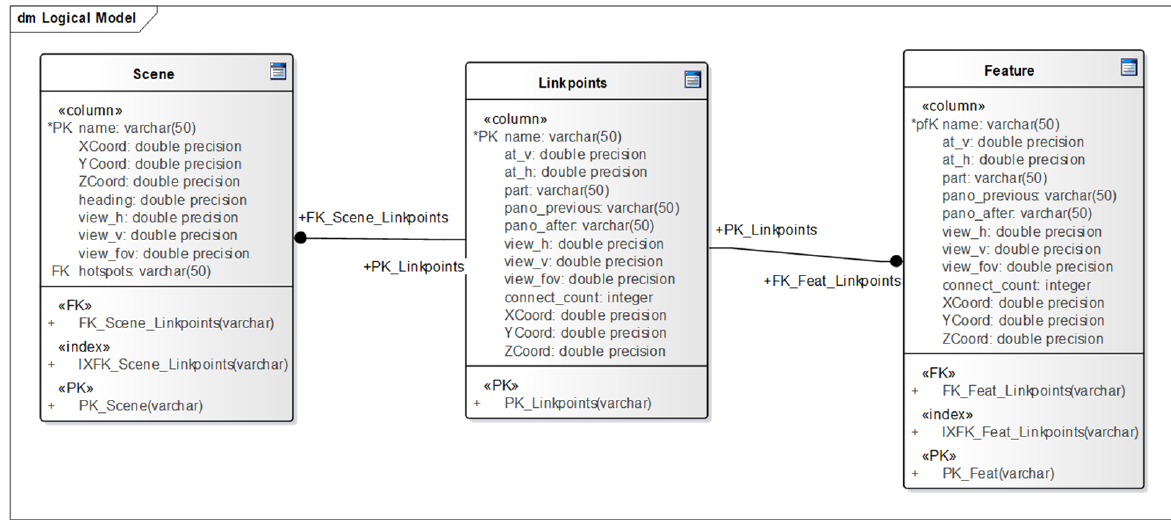
Figure 14. Image parameter database structure obtained from the XML file.